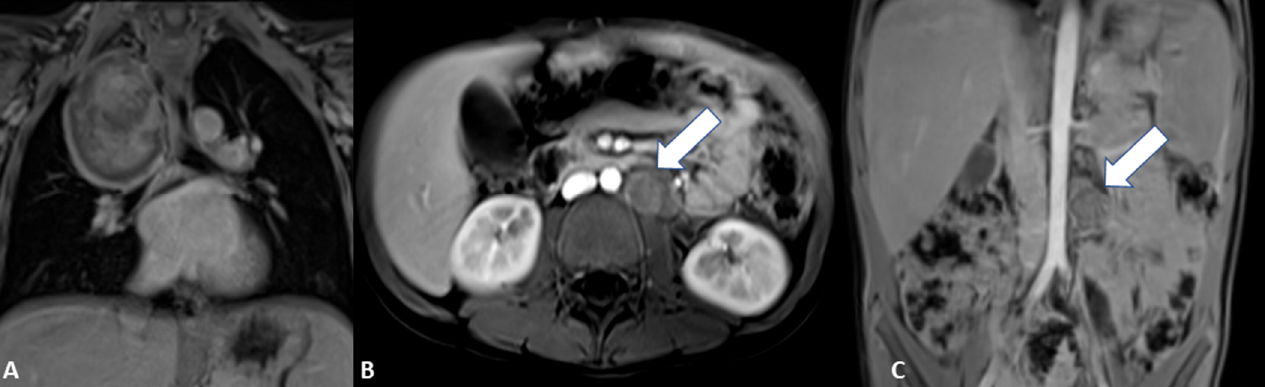
Figure 6. Reevaluation with 123 I ‐ MIBG scintigraphy confirmed the presence of uptake at both ab ‐ dominal ( A – D ) and thoracic level without metastatic lesions ( E – F ).